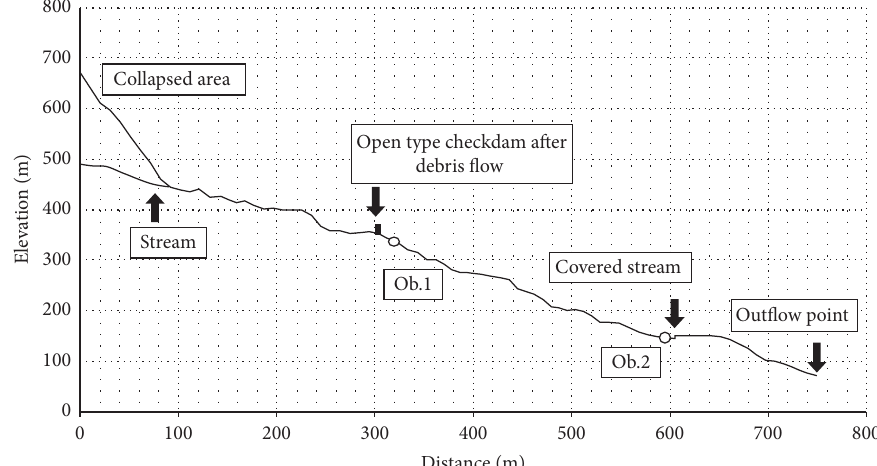
Figure 10: Longitudinal profile of the analysis section and status of modeling comparison points of observation points (Ob. 1 and Ob. 2) assess the open-type check dam’s functions.